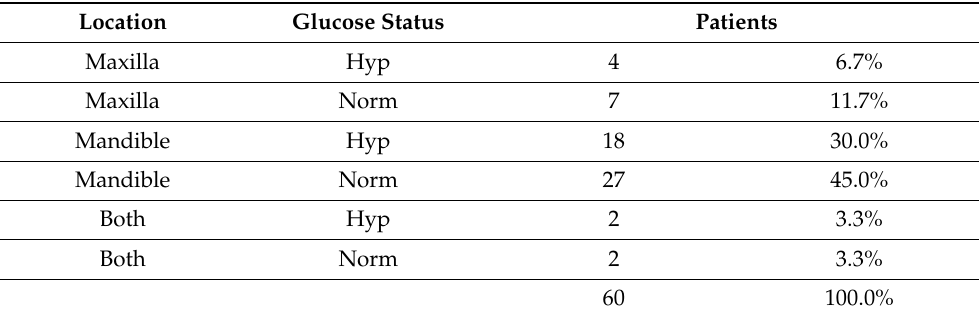
Table 2. The location of MRONJ and the glucose levels were expressed as percentages in the necrosis group. The association between dysglycemia and the location of MRONJ is shown.